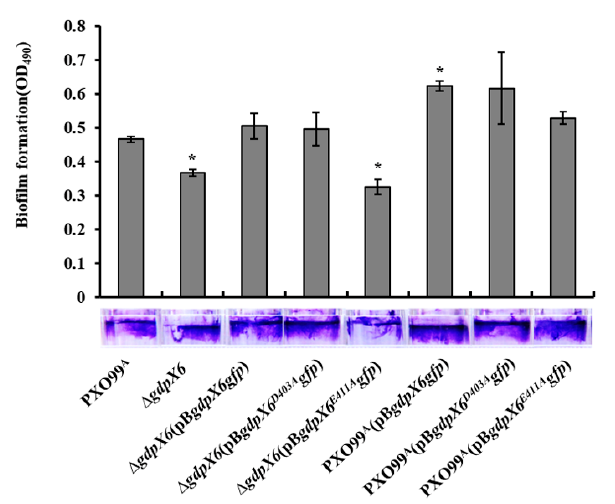
Figure 6. GdpX6 promoted biofilm formation of Xoo . Biofilm formation of all Xoo strains were tested by crystal violet staining method in polystyrene 96-well microplates. After suspension in ethanol, biofilm was quantified by measuring the optical density at 490 nm. Error bars represent standard deviations from three biological repeats. * indicates P < 0.05 as determined by t ‐ test .